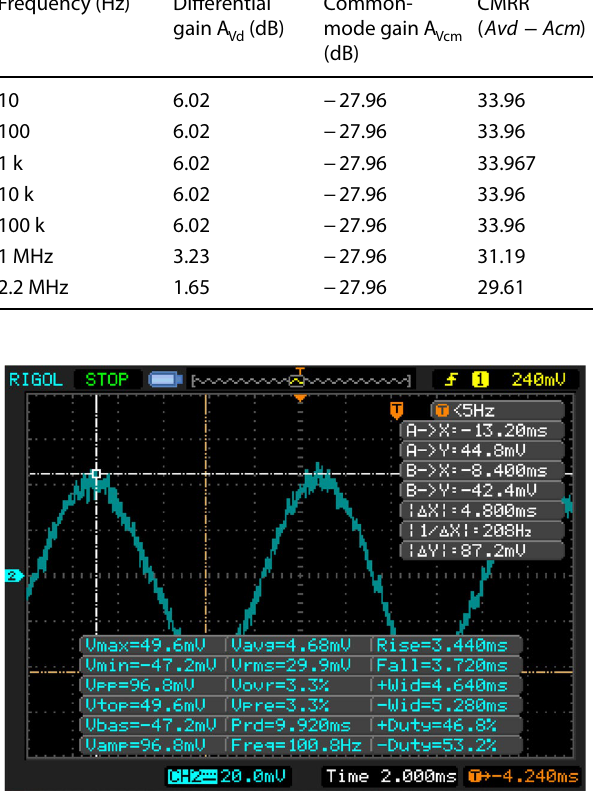
Table 3 Slew rate computation for frequencies of 100 Hz–1 MHz for 100 mV Frequency (Hz)